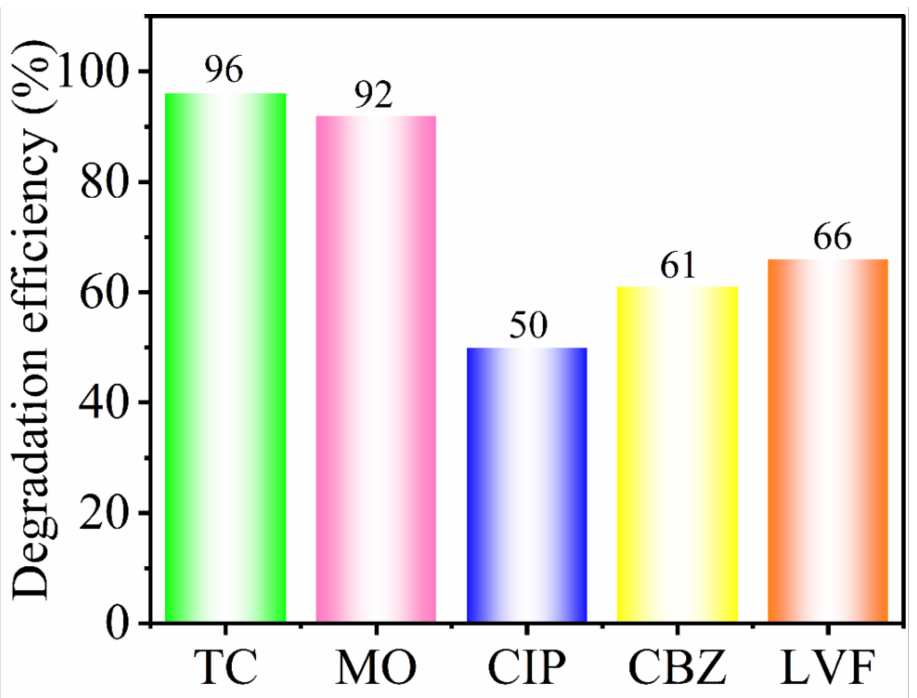
Figure 13. PEC degradation efficiency of different organic pollutants (30 mg/L TC, 20 mg/L CIP, 15 mg/L CBZ, 15 mg/L MO, and 15 mg/L LVF solution for 50